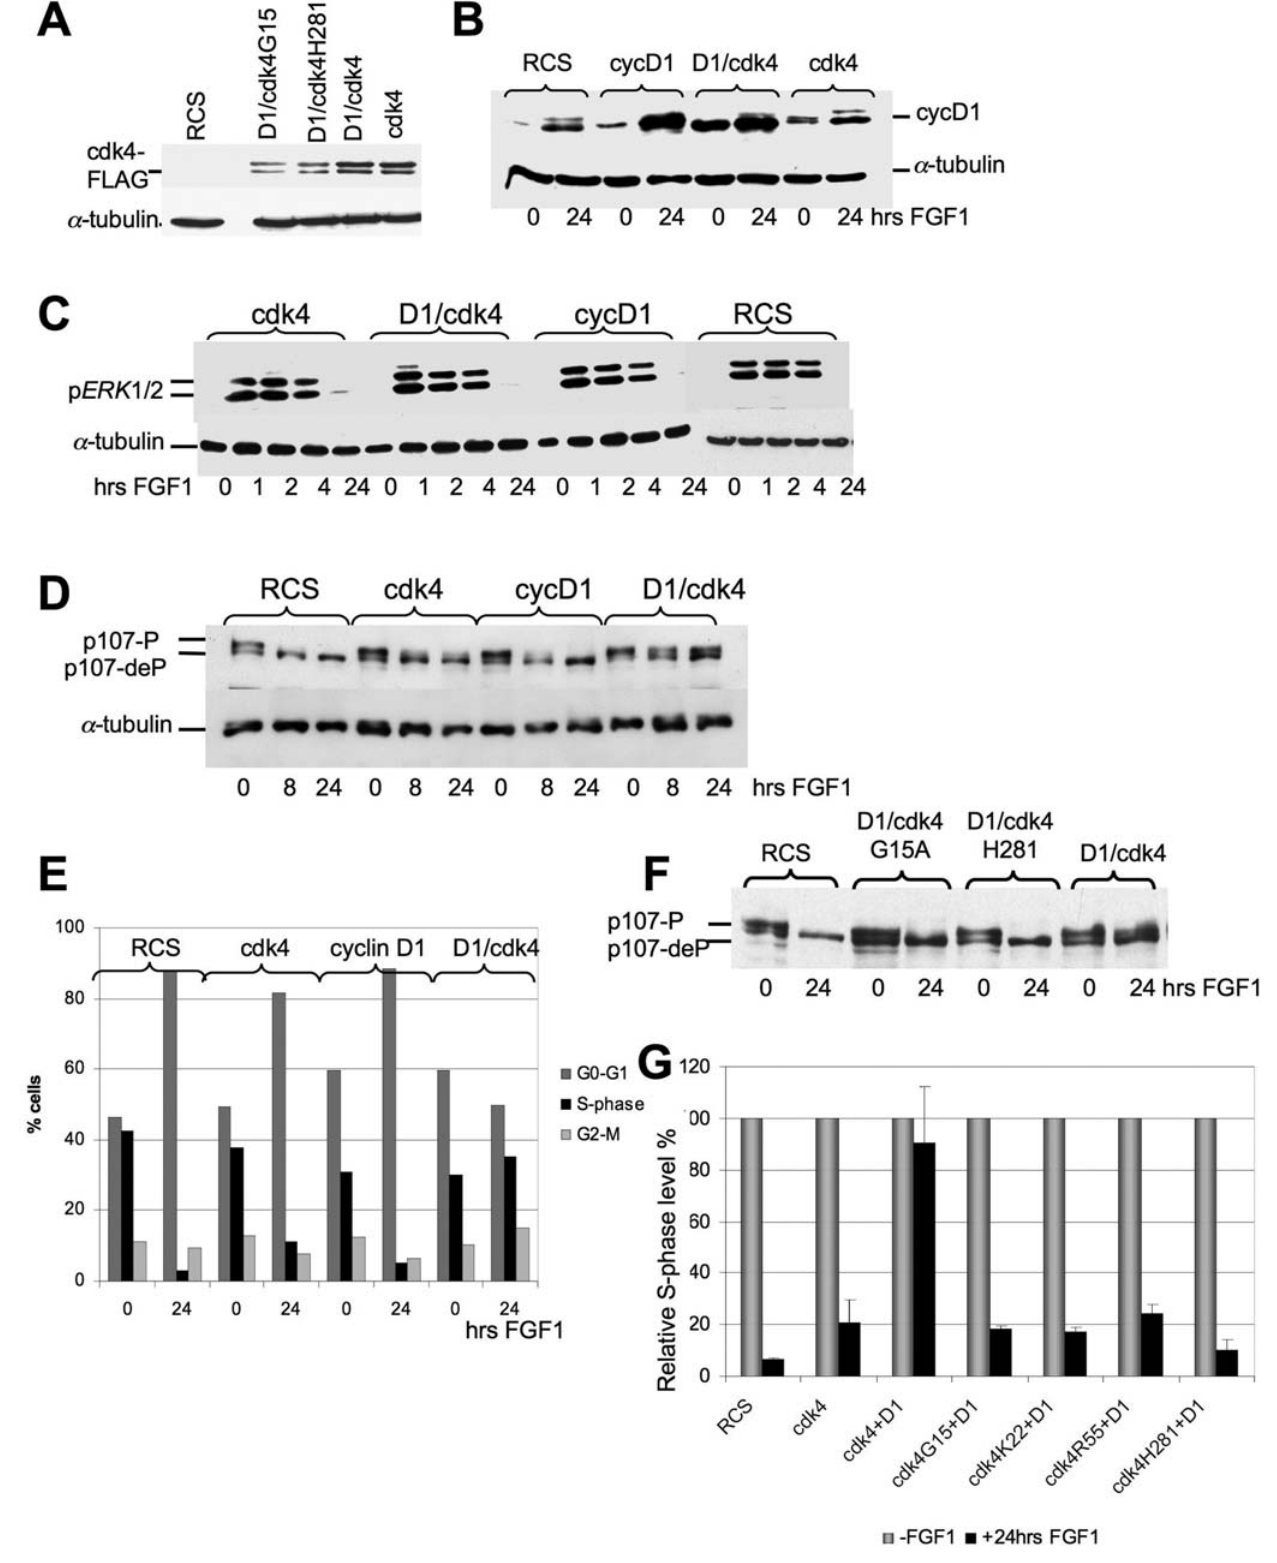
Figure 1. Overexpression of an active cyclin D1/cdk4 complex prevents p107 dephosphorylation and cell-cycle arrest in FGF- treated RCS. Cyclin D1 and cdk4 were stably introduced into RCS cells either independently or in combination and these cell lines were treated with FGF1 for the indicated periods of time. 20 m g of total protein from all indicated cell lines were analyzed by SDS-PAGE followed by immunoblotting. Equal amount of protein loading was confirmed by a -tubulin immunodetection. (A) Anti-FLAG antibodies identify two bands in the cell lines